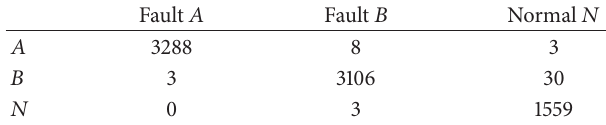
Table 2: Integrate the results using hybrid voting